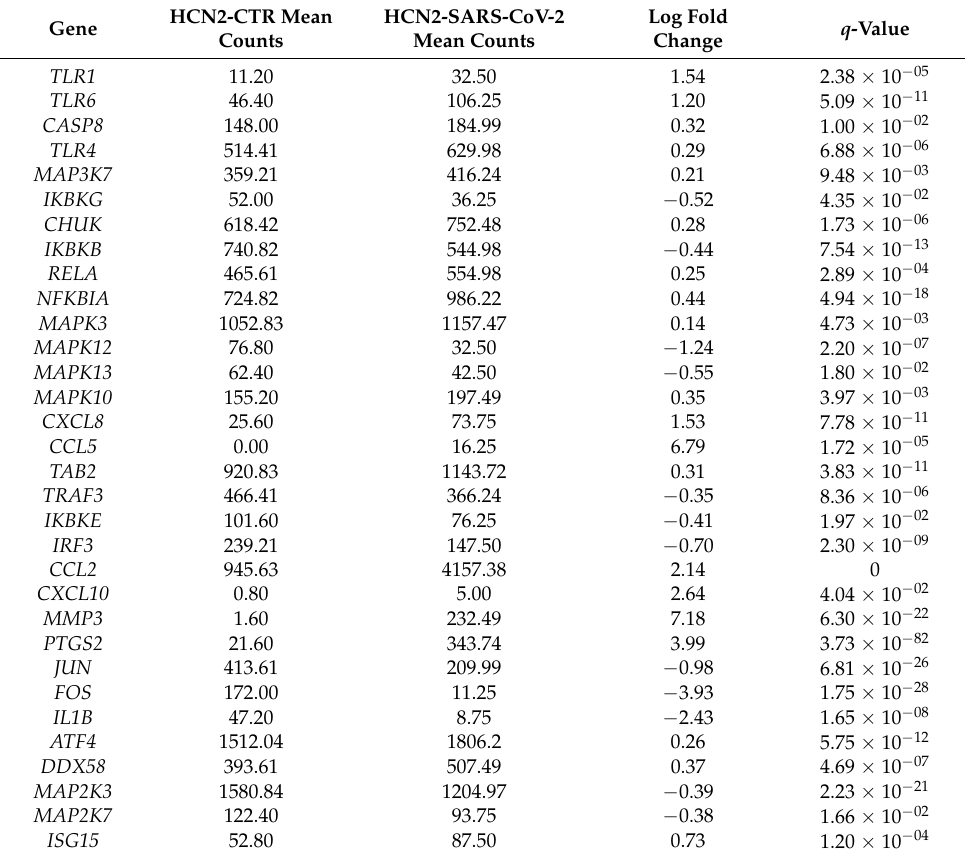
Table 2. DEGs included in the immune response to SARS-CoV-2 in HCN-2